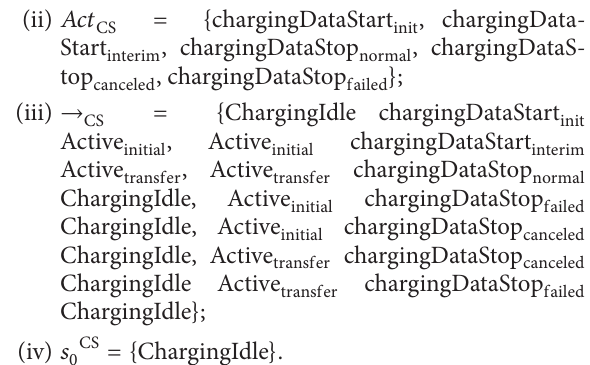
Figure 9: Charging session state